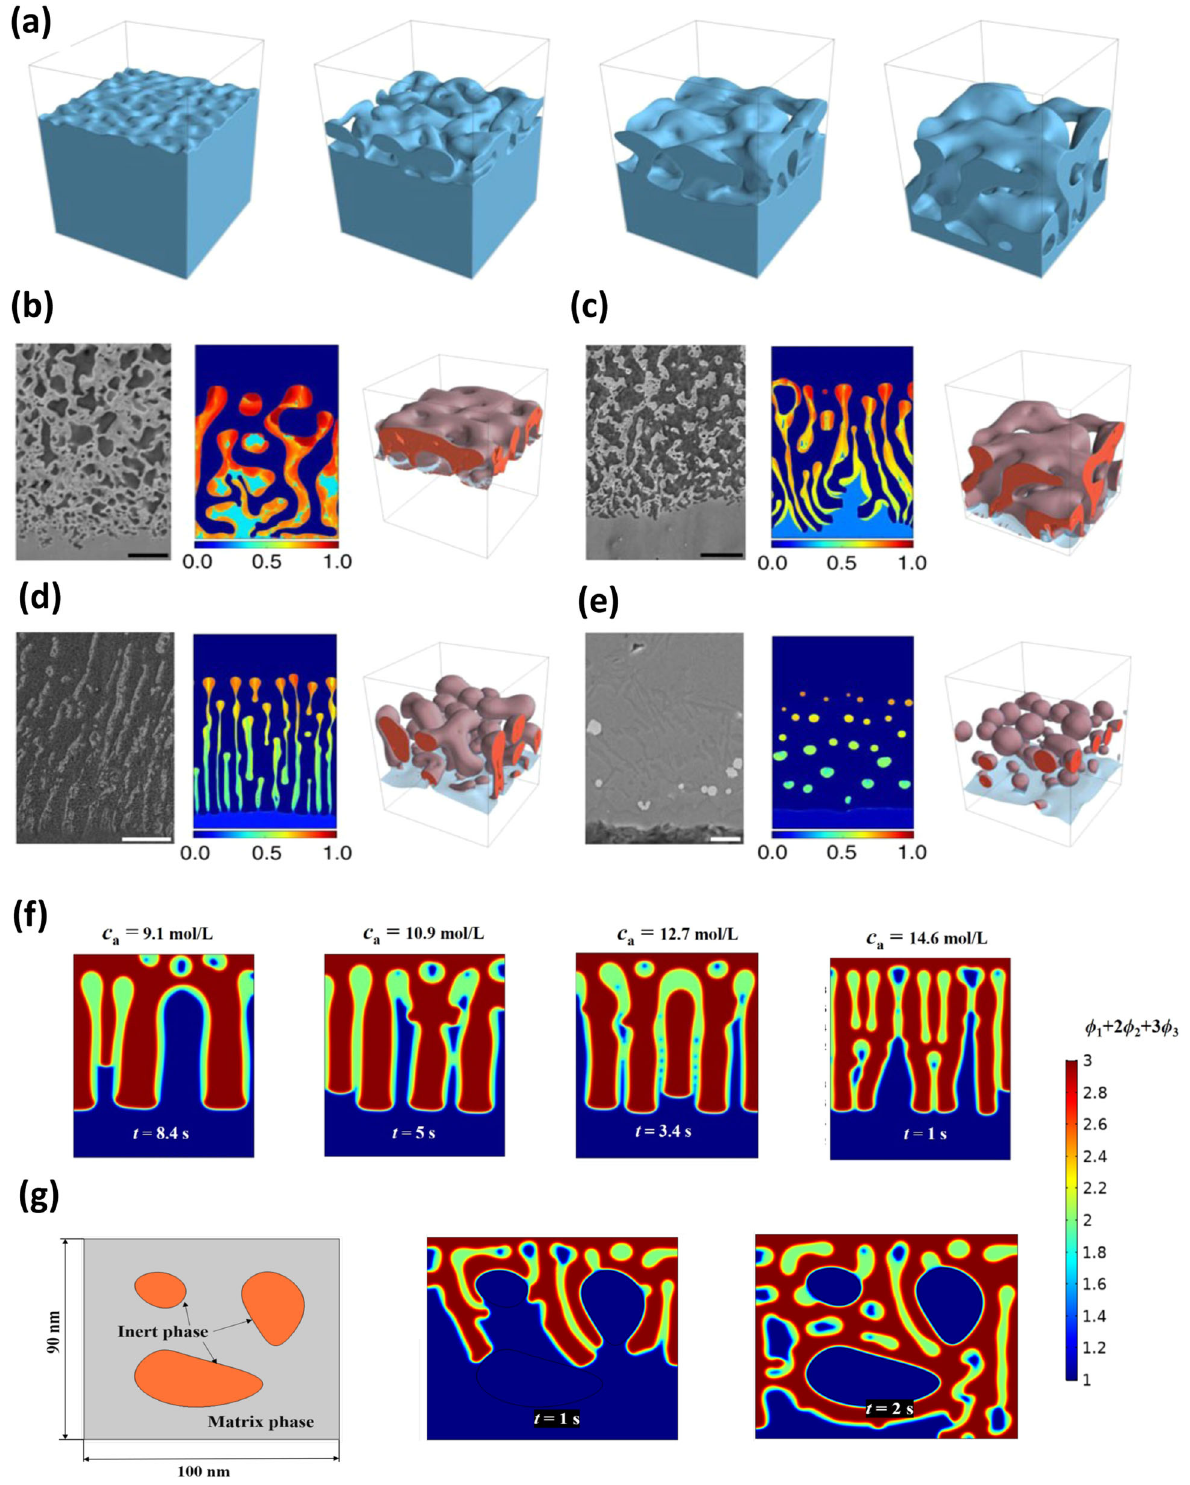
Fig. 8 Porous Structure formation. a 3-D simulations of the evolution of binary alloy A c 0 B 1 − c 0 in a liquid metal bath C, where c 0 is 25%. The simulations and SEM results are shown from experimental setups with ( b ) c 0 = 35%, ( c ) c 0 = 25%, ( d ) c 0 = 15% and ( e ) c 0 = 5% 125 . f Effect of variation in the acidic solution molarity on the nano-porous structure morphology and rate 56 . g Nano-porous structure formation in the presence of an inert phase 56 . a – d are reproduced with permission from ref. 125 , published by nature springer in 2015. f , g are reproduced with permission from ref. 56 , published by Elsevier in